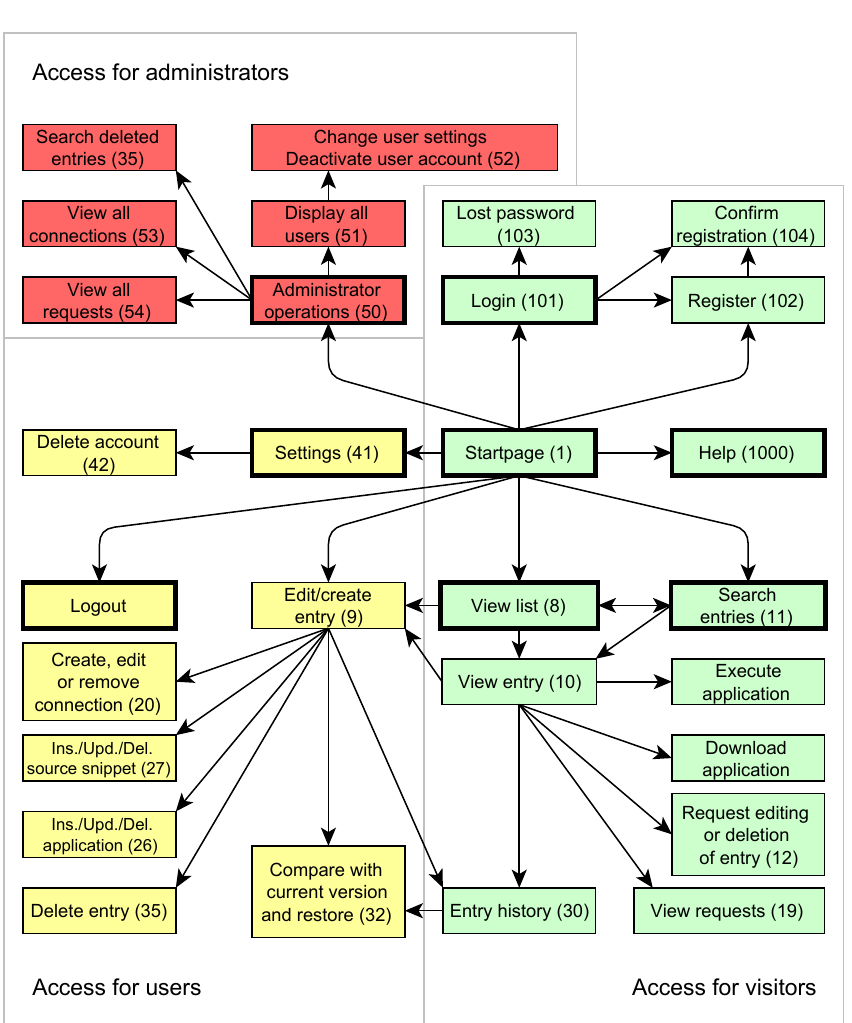
Figure 3: Site map of the BiNCo-wiki web site. Each box represents one page of BiNCo-wiki. The numbers represent the Oracle Application Express page ID. Boxes without numbers are scripts. Boxes with a bold border have a link in the tab bar. Green boxes are available for visitors, users and administrators, yellow boxes are available for users and administrators and red boxes are available for administrators